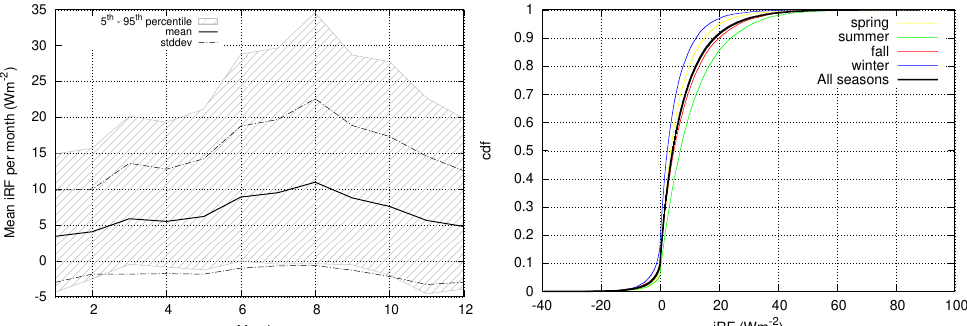
Figure 2. Left panel : Seasonal variation of the mean instantaneous radiative forcing (thick black line) plus/minus one standard deviation (dash-dotted lines) for the years 2000 to 2009. The hatched area covers the 5–95% inter-percentile range. Right panel : Distribution functions (cdfs) for each season (all years, coloured) and the overall cdf